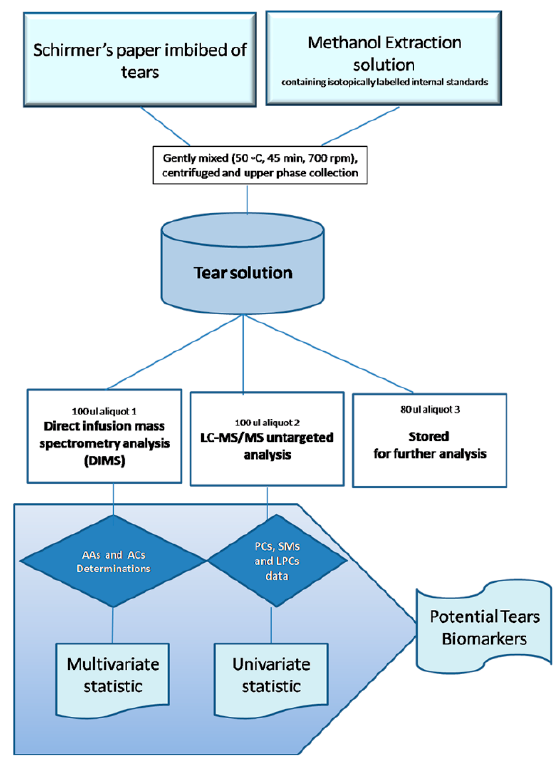
Figure 2. Workflow of tear lipidomics and metabolomics strategy. The scheme summarizes the extraction procedure phases for both lipidomics LC-MS/MS analysis and for targeted metabolomics DIMS analysis.